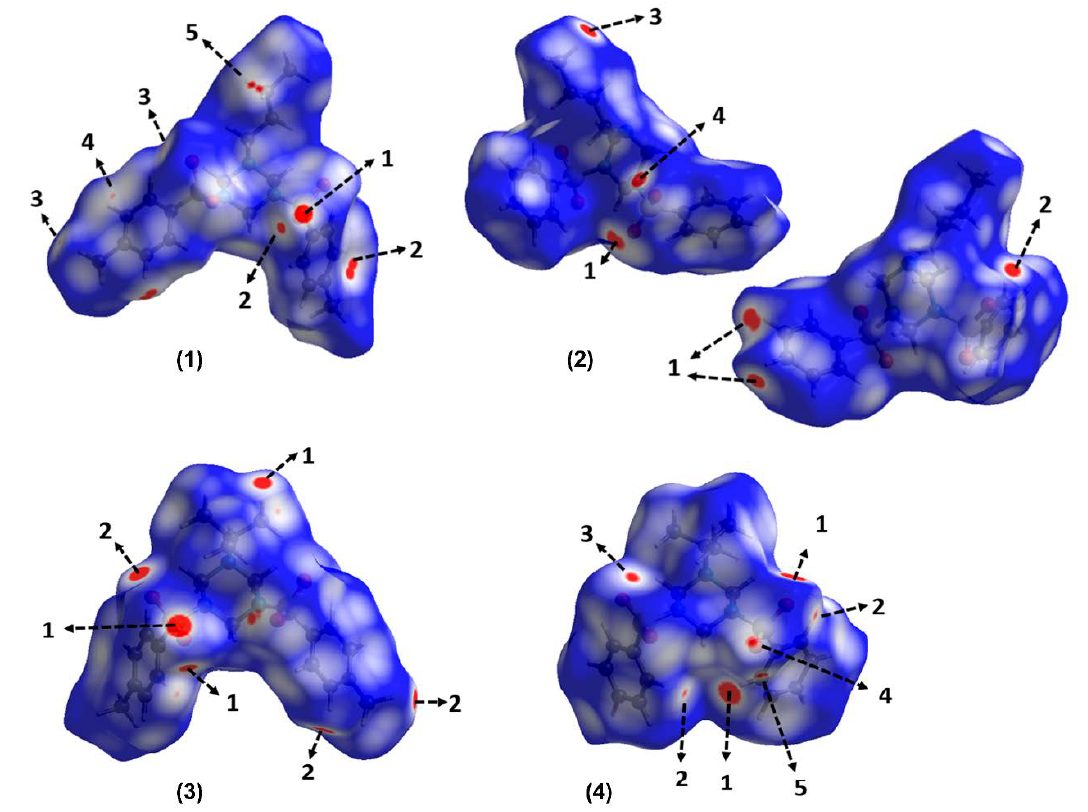
Figure 6. Hirshfeld surfaces mapped over d norm function for compounds 1 – 4 . The labels are discussed in the text. For compound ( 2 ), the second molecule is rotated by 180 ° around the vertical axis of the plot.